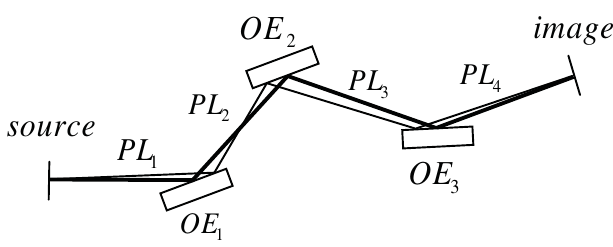
FIG. 3. The principle ray (thick line) between a source and an image point has zero derivatives with respect to all optical element coordinates. In geometrical optics, only these rays are regarded. In physical optics, all possible paths have to be evaluated (e.g. thin